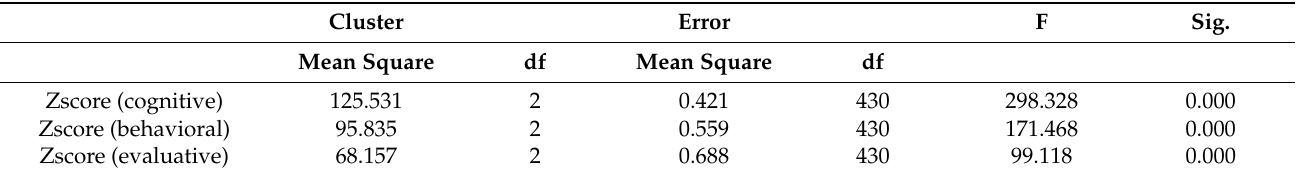
Table 8. ANOVA analysis for 3